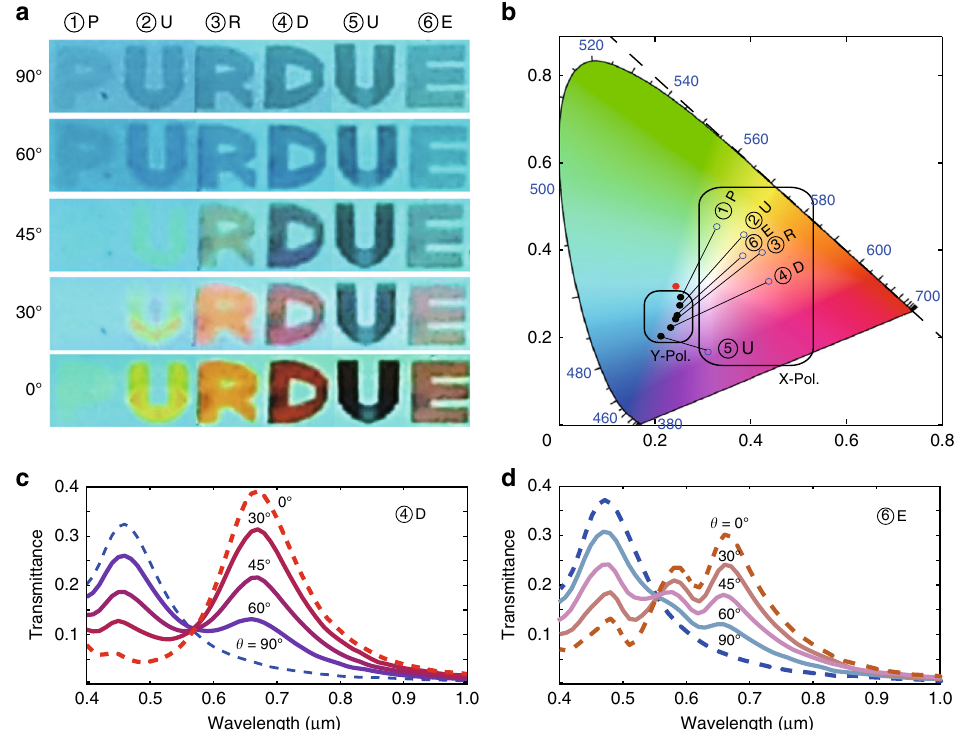
Fig. 4 Bandpass colour fi ltering with the metasurface-based nanocavities in the visible range. a Colour image of the nanocavity with different linewidth. White light illuminates the sample via a linear polarizer. The angle of polarization is varied from 0° to 90°. b The variation of colour with angle of polarization is analyzed with the CIE 1931 colour mapping. The red dot represents the background colour. c , d The transmission spectra of nanocavity at different angle of polarization: c for sample 4 (letter ‘ D ’ ) and d for sample 6 (letter ‘ E ’